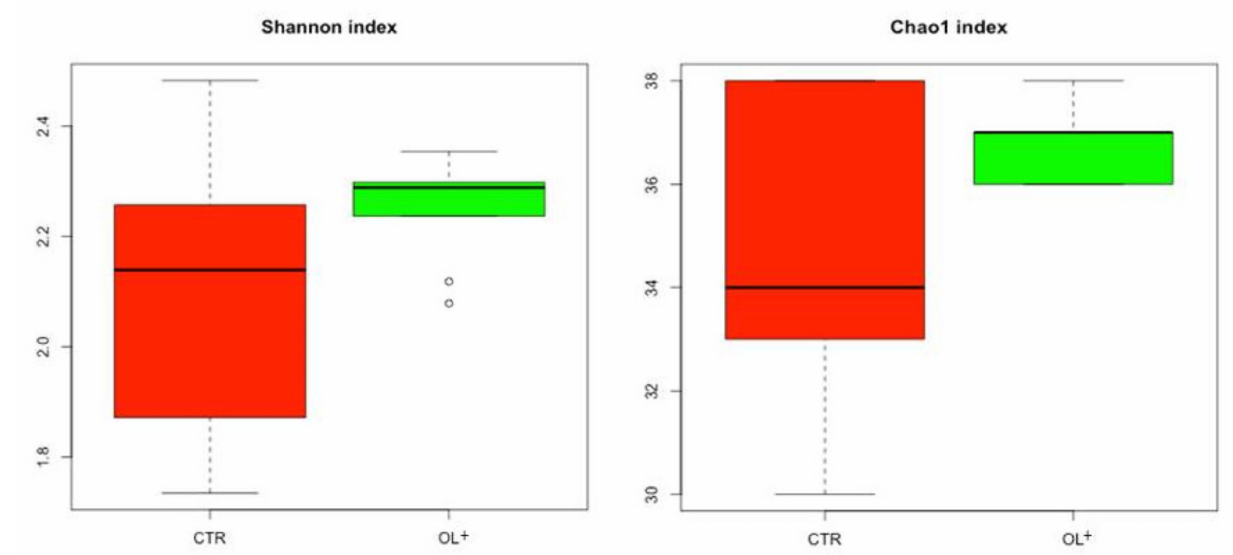
Figure 1. Alpha diversity between control group (CTR—red) and experimental group